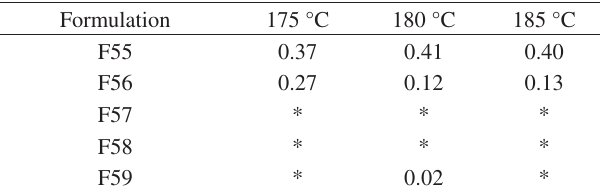
Table 3. Flow behavior index n.